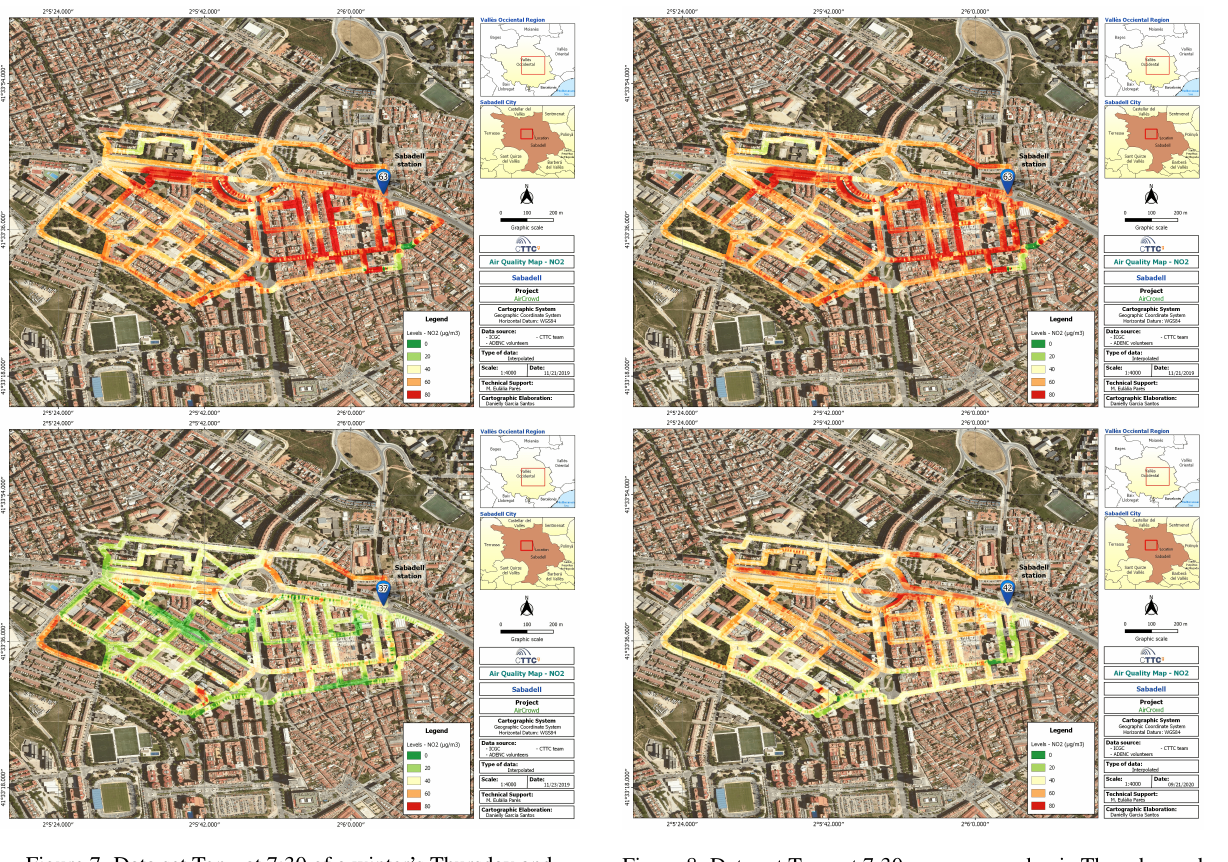
Figure 8. Data set Top.- at 7:30 on a pre-pandemic Thursday and Bottom.- at 7:30 on a pre-pandemic